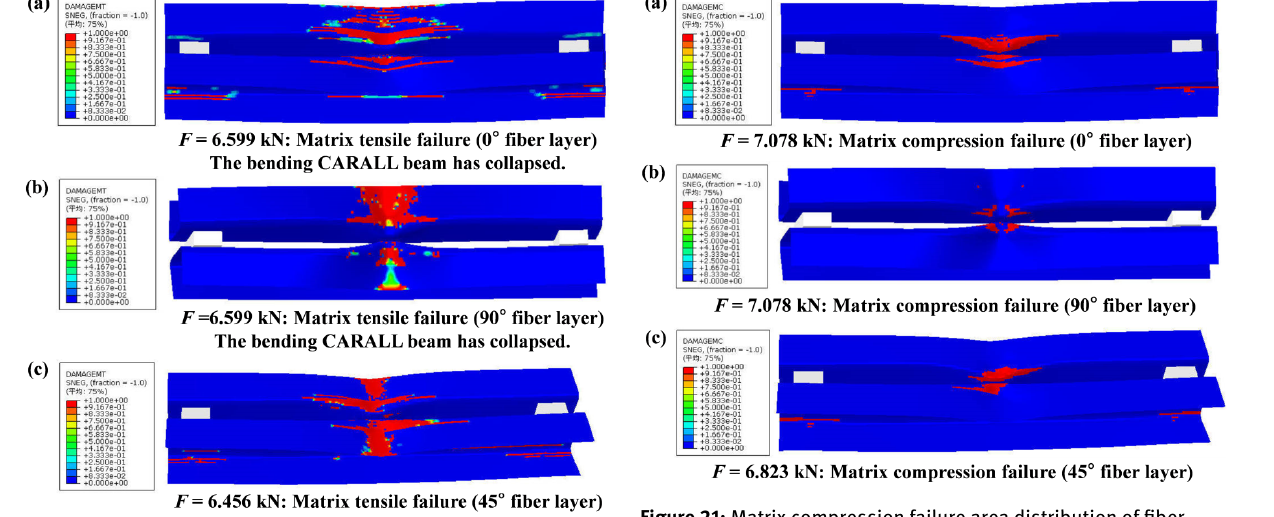
Figure 21: Matrix compression failure area distribution of fiber layers in ultimate bearing state: (a) SHCXL-A: 0 ∘ fiber layer; (b) SHCXL-A: 90 ∘ fiber layer; and (c) SHCXL-B: 45 ∘ fiber layer.